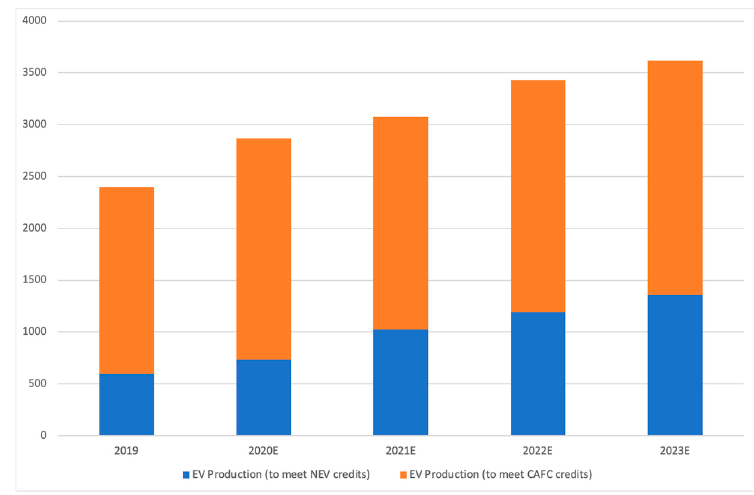
Figure 3. Predicted increase in EV production in China (unit: thousand).